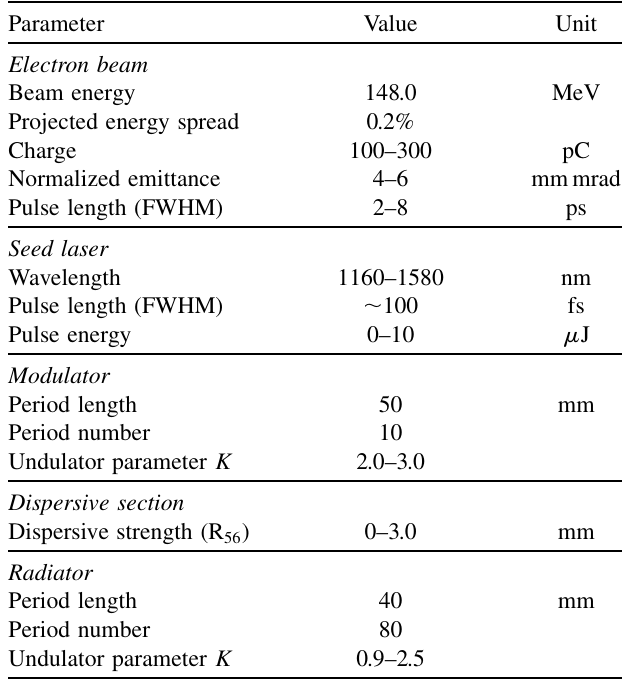
TABLE I. Main parameters of the SDUV-FEL. Parameter